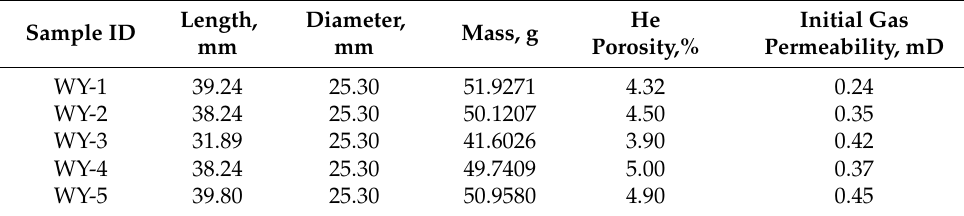
Table 1. Basic information of the experimental sample.